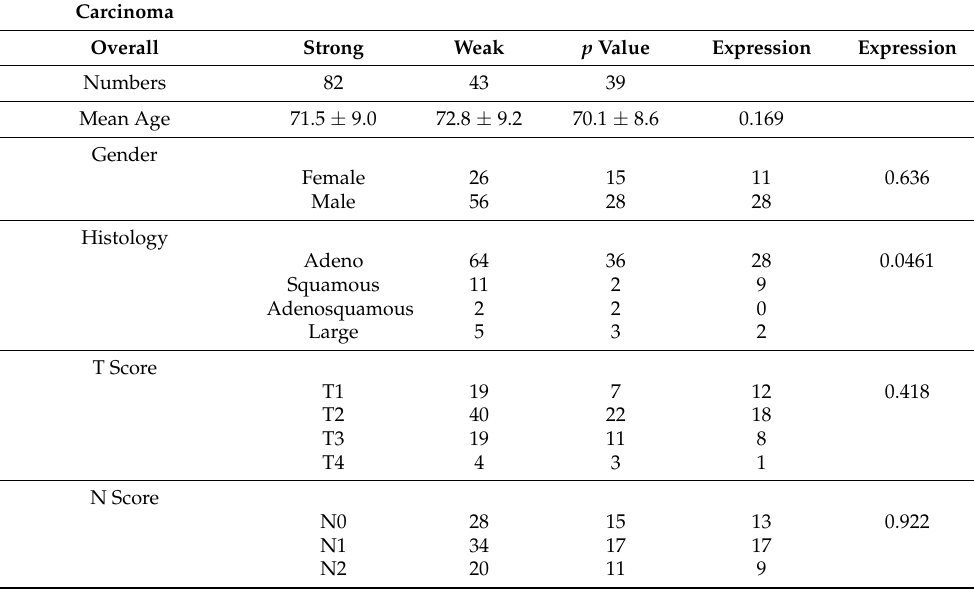
Table 1. CXCL12 status and clinicopathological parameters in non-small cell lung